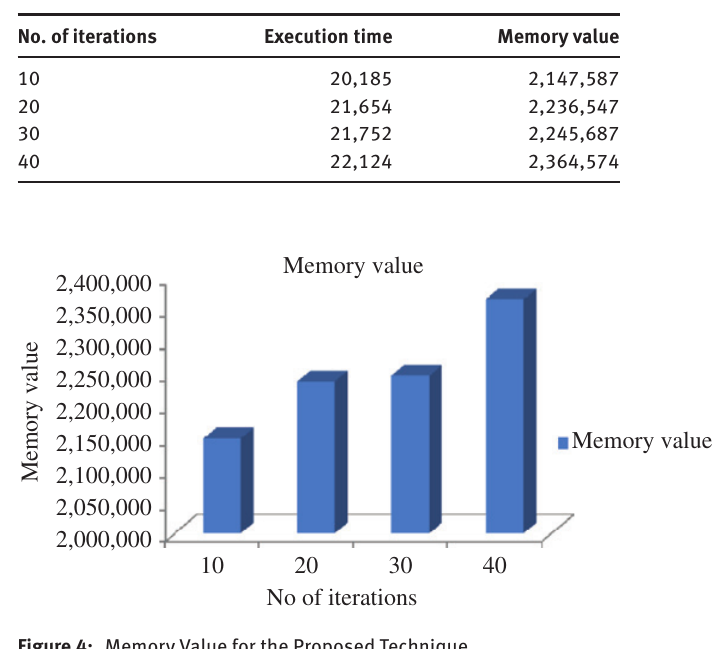
Table 2: Memory Value and Execution Time of the Proposed Method.